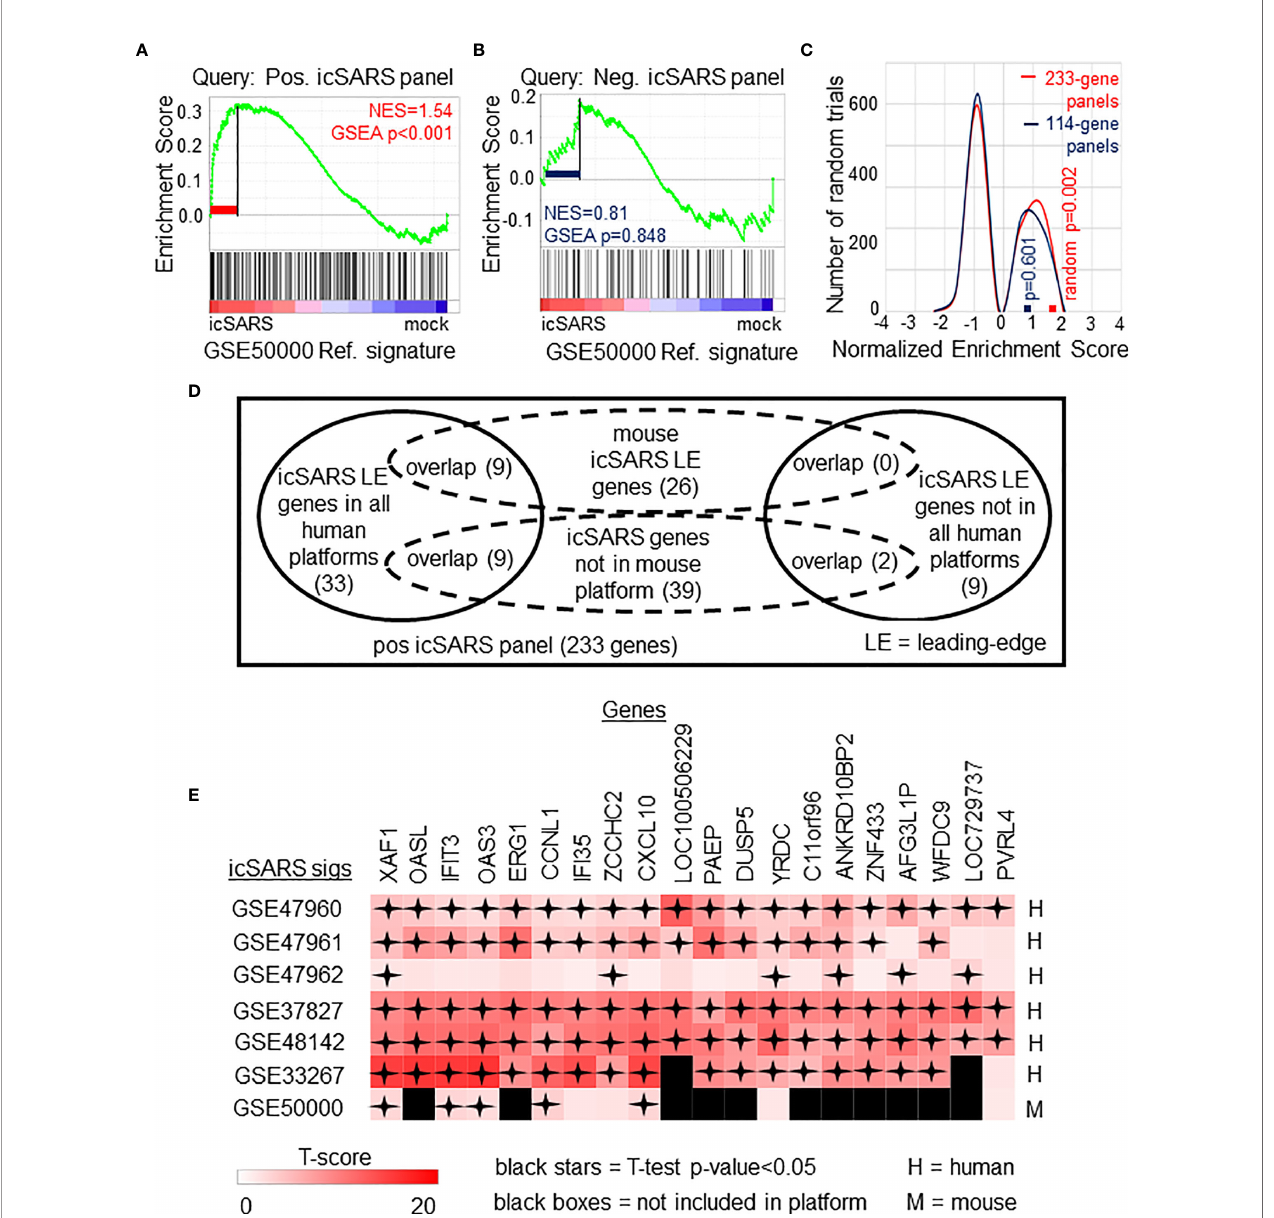
FIGURE 3 | Positive icSARS Panel Enrichment in icSARS Infected Mouse Model Revealed Genes Associated with icSARS Infection. (A) Gene Set Enrichment Analysis (GSEA) calculated enrichment, as determined by normalized enrichment score (NES), between the positive icSARS gene panel and the GSE50000-derived icSARSvsmock gene signature. (B) GSEA between the negative icSARS panel and the GSE50000-derived icSARSvsmock signature. (C) Distribution plot of NES from 1000 randomly generated gene panels (individual queries) compared to the GSE50000-derived icSARSvsmock signature (reference). (D) Venn diagram of the inclusion and overlap of positive icSARS panel genes in identi fi ed leading-edges and dataset platforms across icSARS-CoV human and mouse gene signatures. (E) Heat map of T − scores for the 20 positive icSARS panel leading-edge genes identi fi ed in (D)